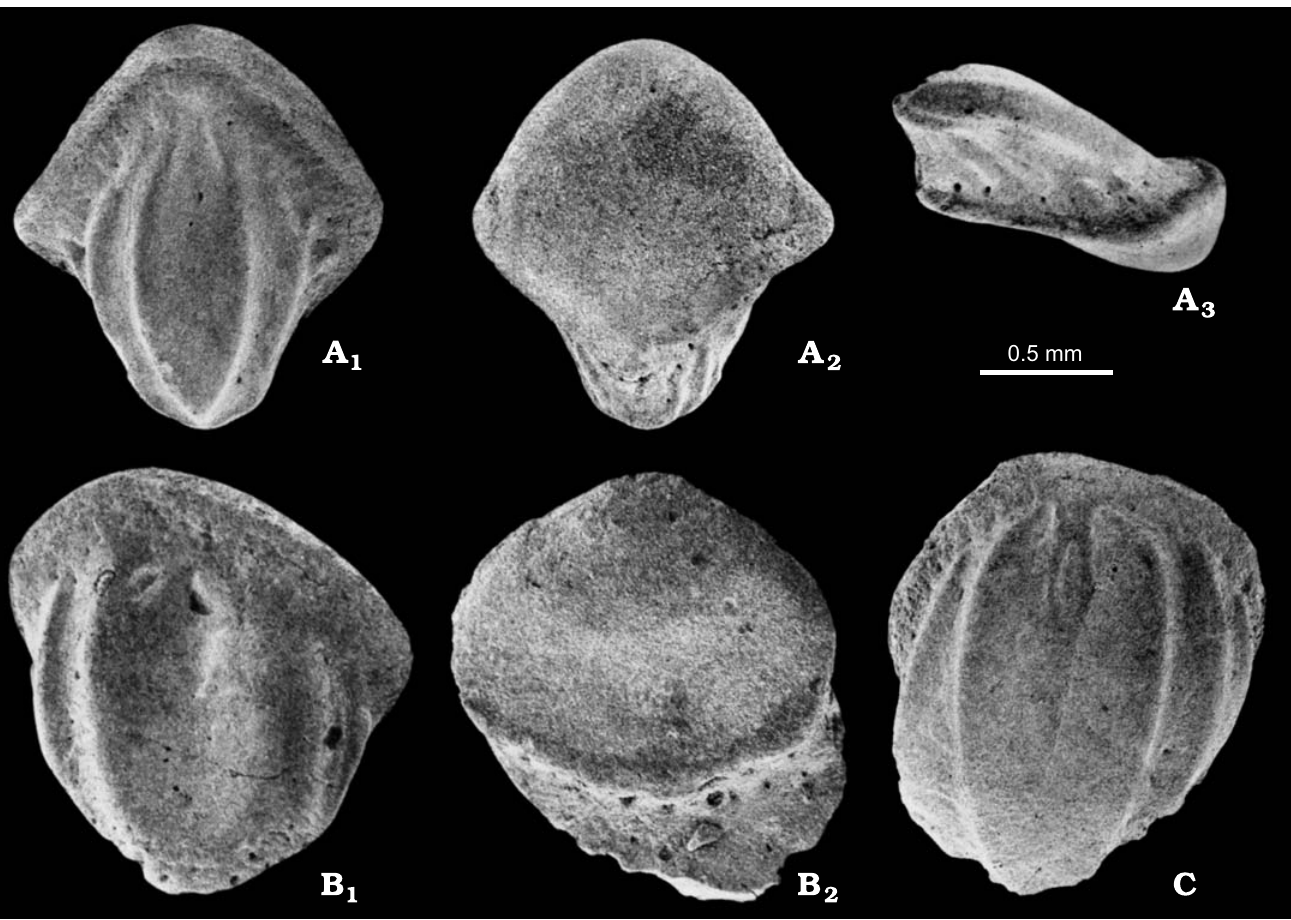
Fig. 3. Climatiid acanthodian Iranolepis ginteri gen. et sp. nov. from early Frasnian, horizon GI4 of an unnamed formation in the Chahriseh section, Kaftari Mt., central Iran. SEM micrographs of flank scales. A . Holotype, AEU 301 in crown (A 1 , anterior upward), basal (A 2 , anterior upward), and lateral (A 3 , an− terior to right) views. B . AEU 302 in crown (B 1 ) and basal (B 2 ) views. C . AEU 303 in crown view. In B 1 , B 2 , and C anterior is upward.